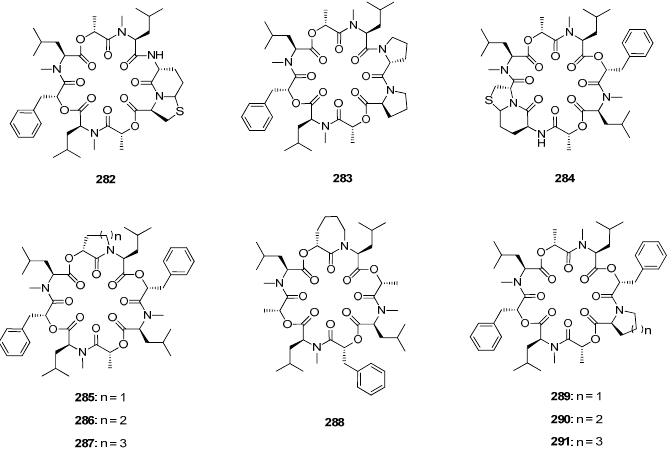
Figure 29. Conformationally restricted analogues of PF1022A ( 235